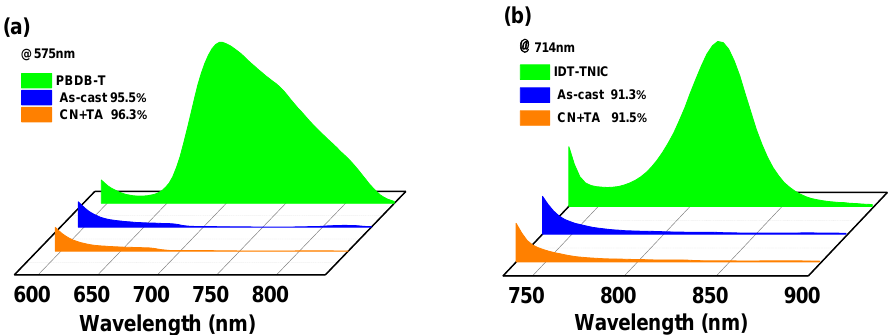
Figure 4. PL spectra of PBDB-T ( a ), IDT-TNIC ( b ) and PBDB-T:IDT-TNIC blend films with excitation